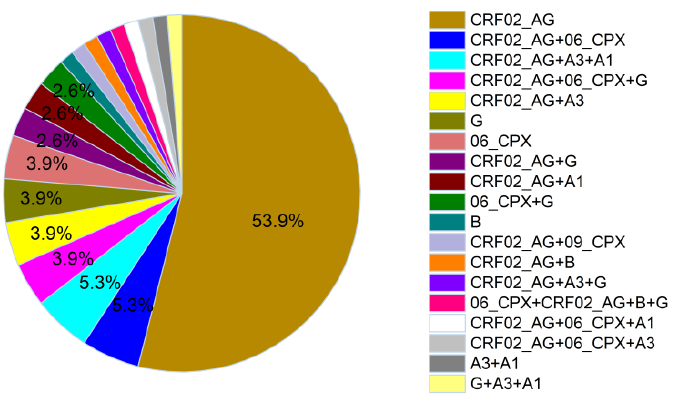
Figure 5. Subtype distribution determined from full HIV genomes (N = 76). Categories indicate subtype composition, not shared breakpoints. Single occurrences are not indicated by percentages.